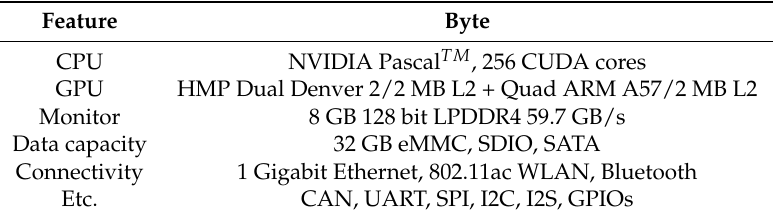
Figure 5. Jetson TX2. Table 3. Jetson TX2 Technical